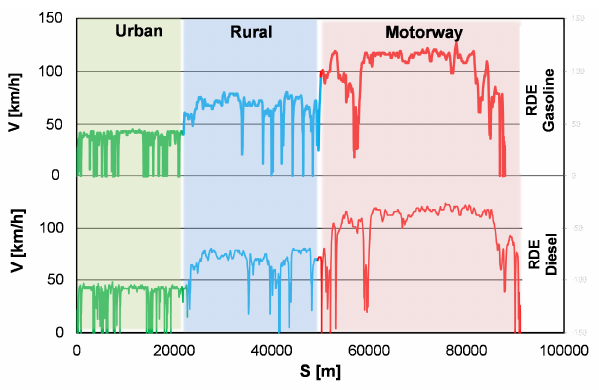
Fig. 4. Velocity of individual test drives